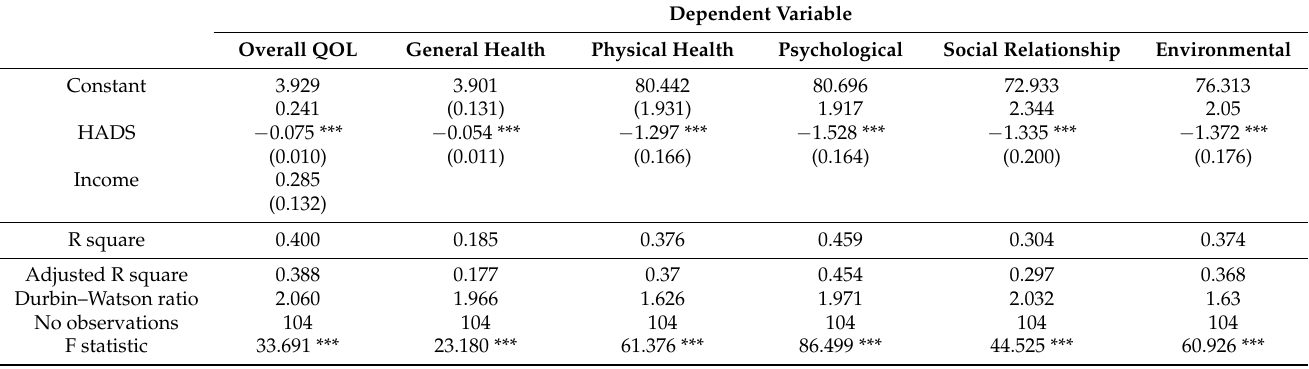
Table 5. Stepwise multiple linear regression analysis for HADS and sociodemographic and clinical factors in relation to